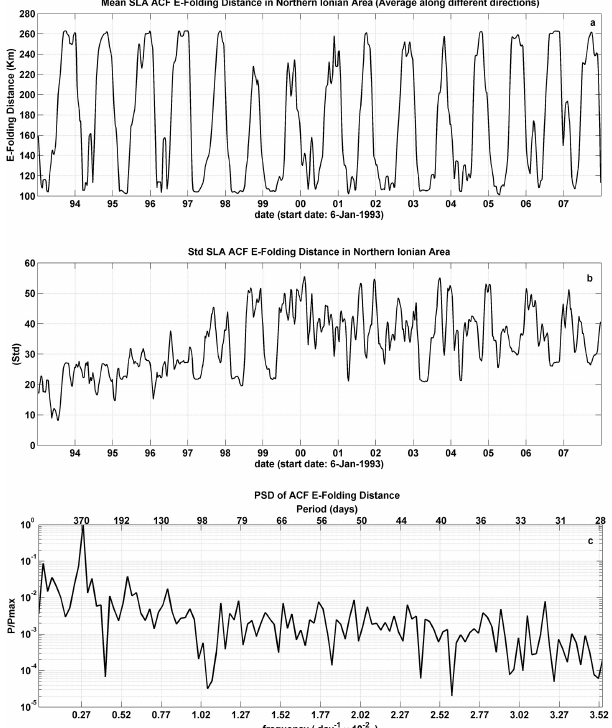
Fig. 3. Temporal variability and frequency spectra of the correlation length scale of the SSH over the Ionian in the period 1993–2007. The correlation length is computed as the average of 17 e-folding distances obtained by fitting the SSH autocorrelation with a Gaus- sian along 17 different radial directions. (a) Average over 17 radial directions between 0 and 90°; (b) standard deviation of the mean of Fig. 5a; (c) power spectrum of Fig. 5a (adapted from Ioannone et al.,